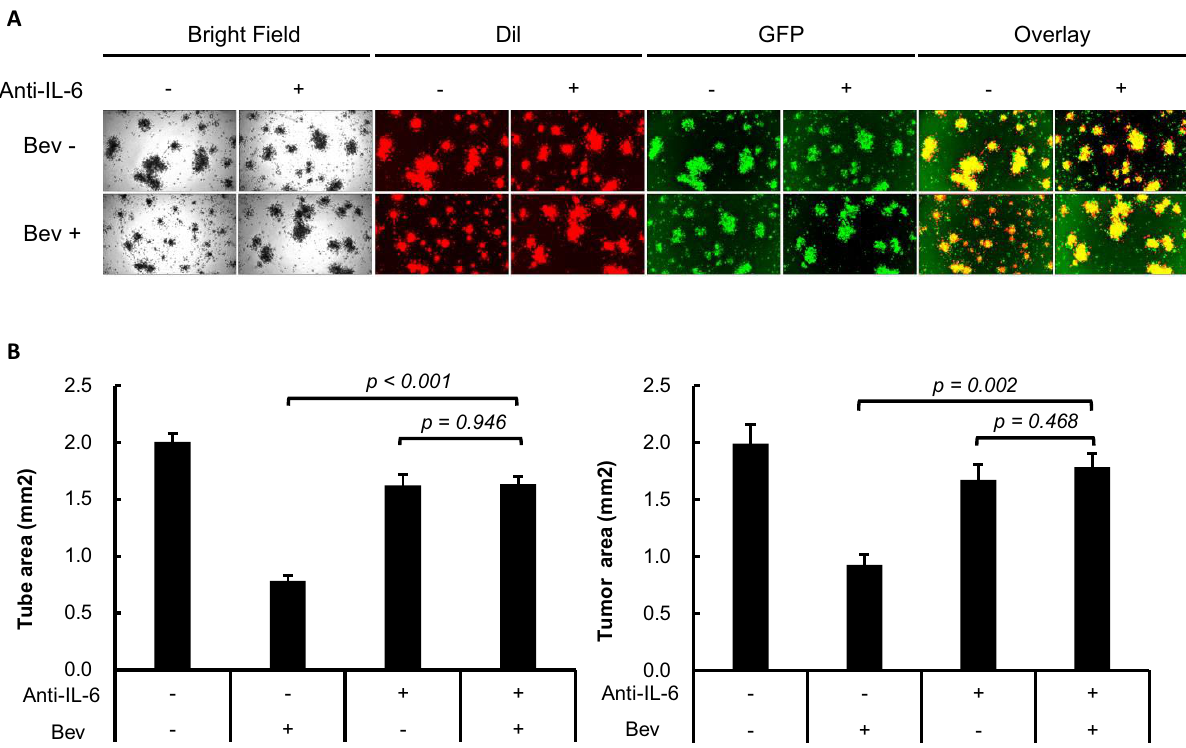
Figure 2. The role of IL-6 signal for the anti-angiogenic and the anti-tumor effects of Bev in 3D co-culture system. ( A ) Representative micrograph of 3D co-culture with or without IL-6 blockade and/or Bev observed through light microscope and fluorescent microscope at experimental day 4. HUVEC was stained by Dil, emitting red fluorescence. RMG-1/GFP was seen as green fluorescence. Overlaid images of Dil and GFP were shown at the rightmost. ( B ) Measured area at day 4 of each color by hybrid cell count software. Dil-stained area, regarded as the tube area, is shown on the left and GFP area, regarded as the tumor area, is shown on the right side. Error bars are SEs. All the images were observed by fluorescence microscope (BZ-X800, Keyence). Then, these obtained images were analyzed by the BZ-H4C analytic application (Keyence) for hybrid cell count and the BZ-H4CM application (Keyence) for macro cell